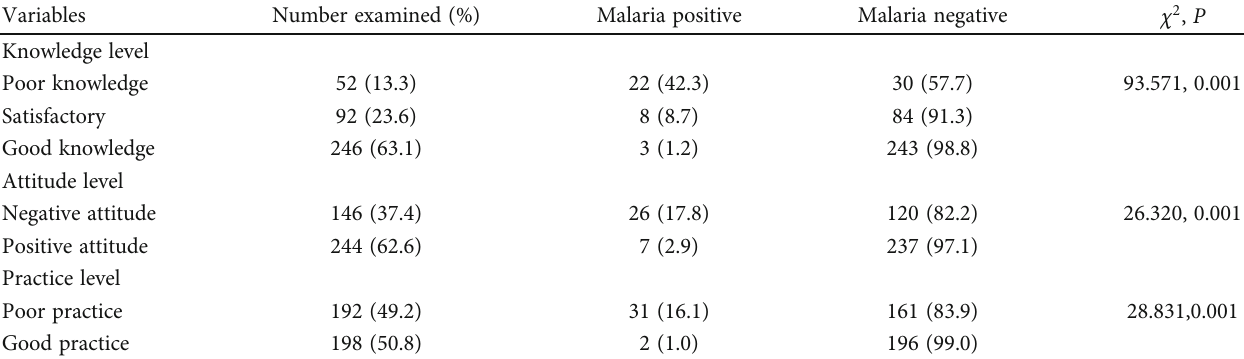
Table 5: Cross tabulation of Chi-square analyses of association of overall knowledge, attitude, and practice scores of the study participants with the prevalence of